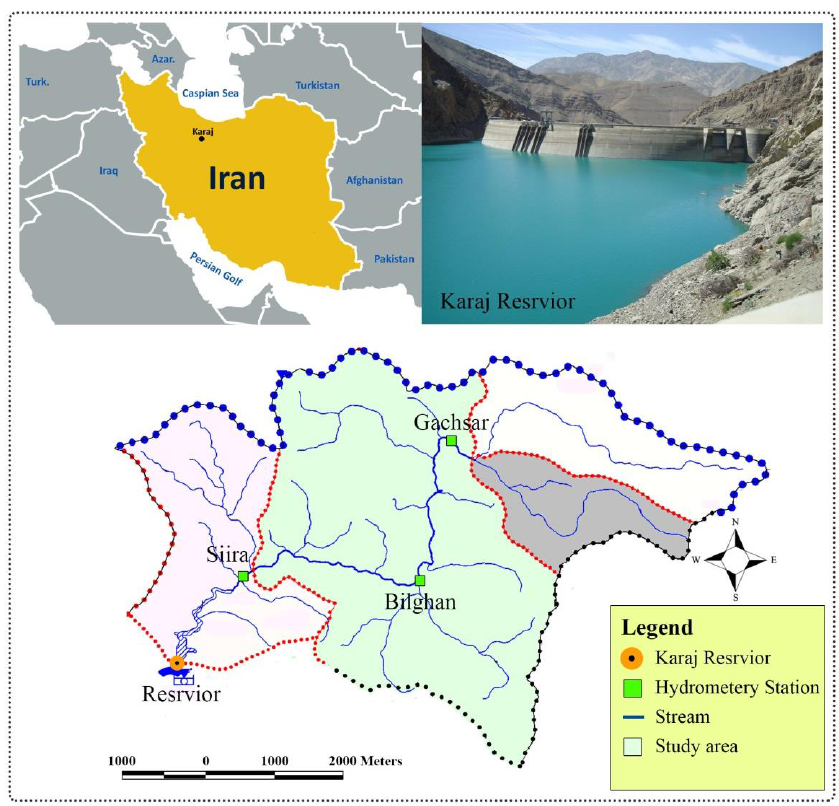
Figure 2. Location map of Karaj reservoir within the Karaj watershed.